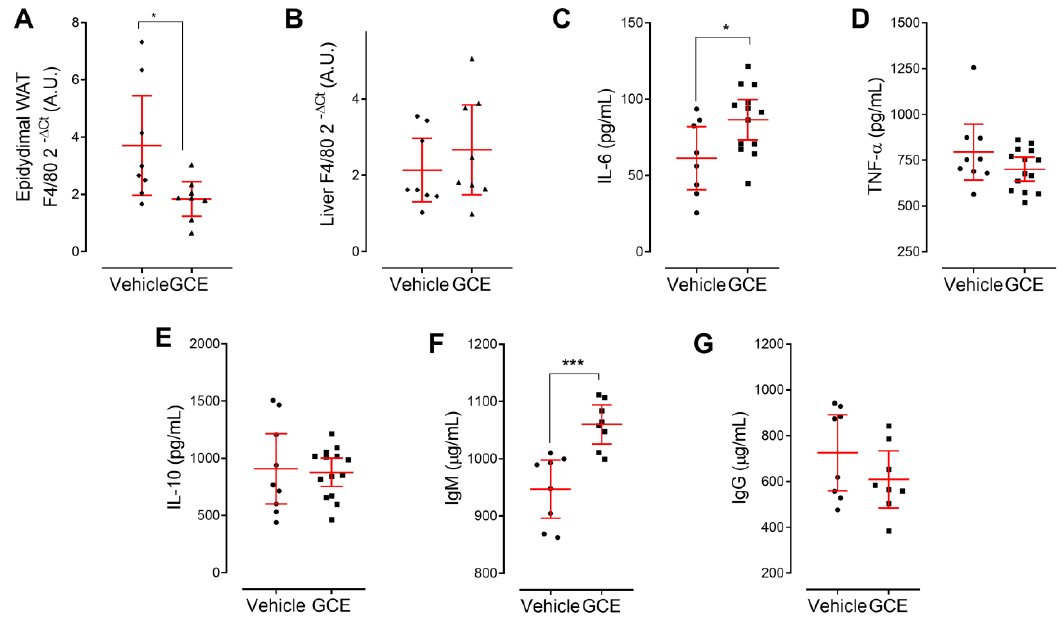
Figure 5. Green coffee extract (GCE) modifies various immune markers in dyslipidemic ApoE -/- mice. The inflammatory status of GCE-treated and control ApoE -/- High-fat diet-fed mice was evaluated via the assessment of immune markers in serum and target organs. The expression levels of (mRNA) for the macrophage marker F4/80 were determined in ( A ) epididymal white adipose tissue (WAT)and ( B ) liver tissues and were expressed as arbitrary units (Arbitrary Units A.U.). ( C – E ) Interleukin 6 (IL-6), tumor necrosis factor α (TNF- α ), and Interleukin 10 (IL-10) were quantified in liver homogenates by ELISA. Total serum IgM ( F ) and IgG ( G ) levels were quantified by ELISA. The results are shown as the mean ± 95% confidence intervals, and p -values from unpaired two-tailed t-tests are expressed as follows: * p < 0.05; *** p < 0.001.